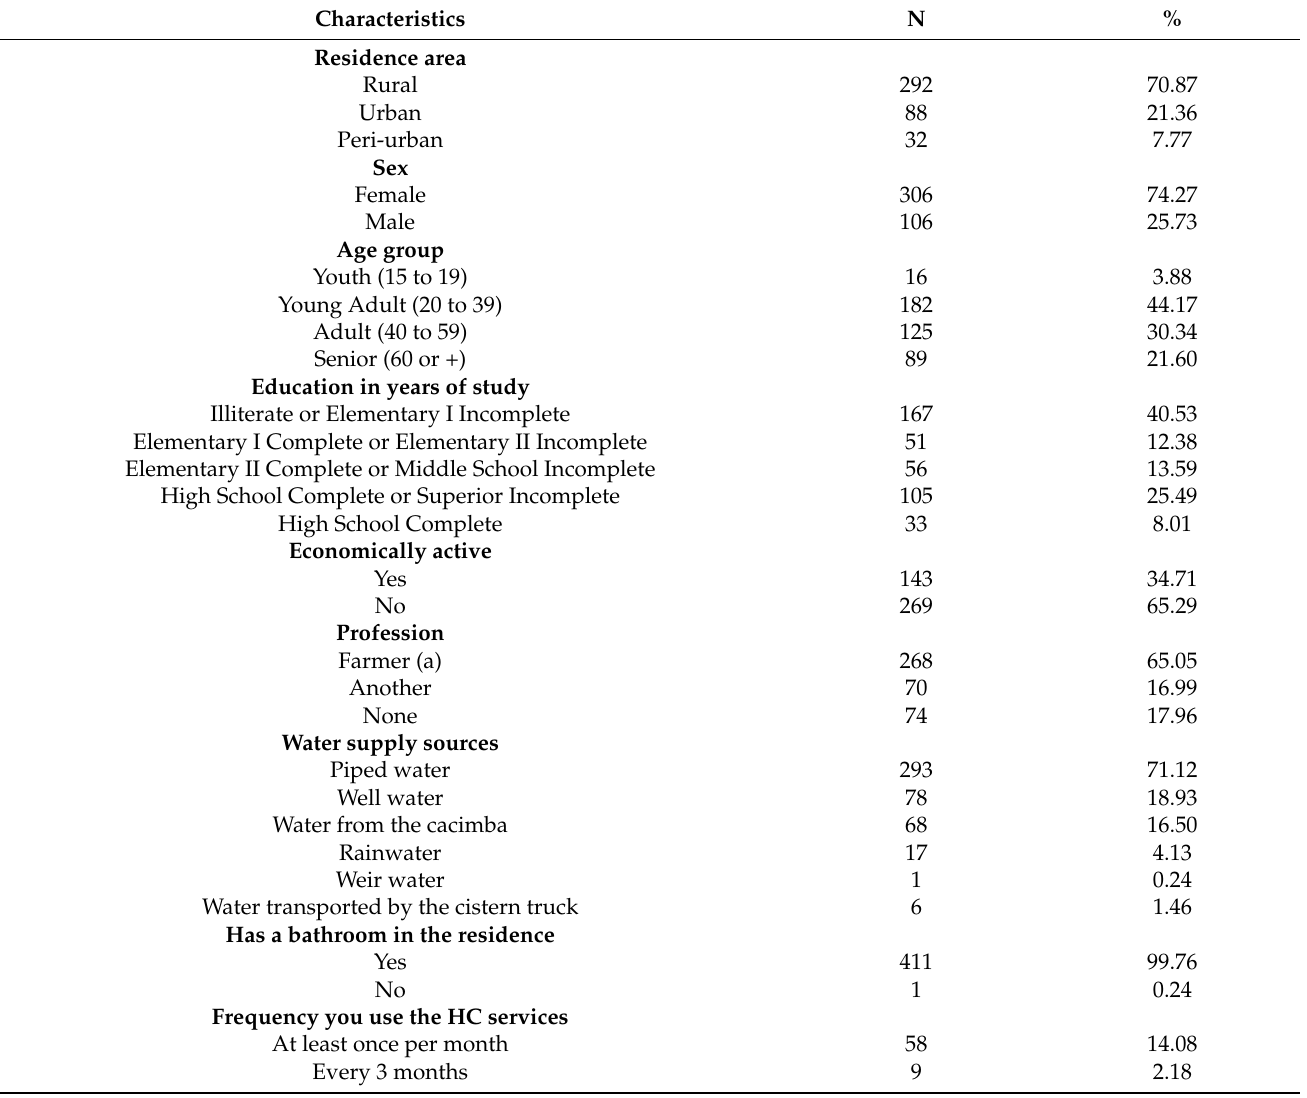
Table 1. Characteristics, sociodemographic and health care demand profiles of residents from Feira Grande, Alagoas, Brazil, in